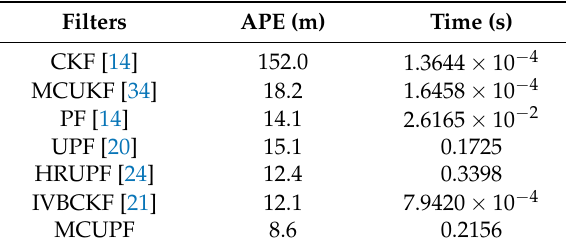
Table 7. Comparisons of averaged position errors (APEs) and computation time in a single step of the proposed filter and existing filters.